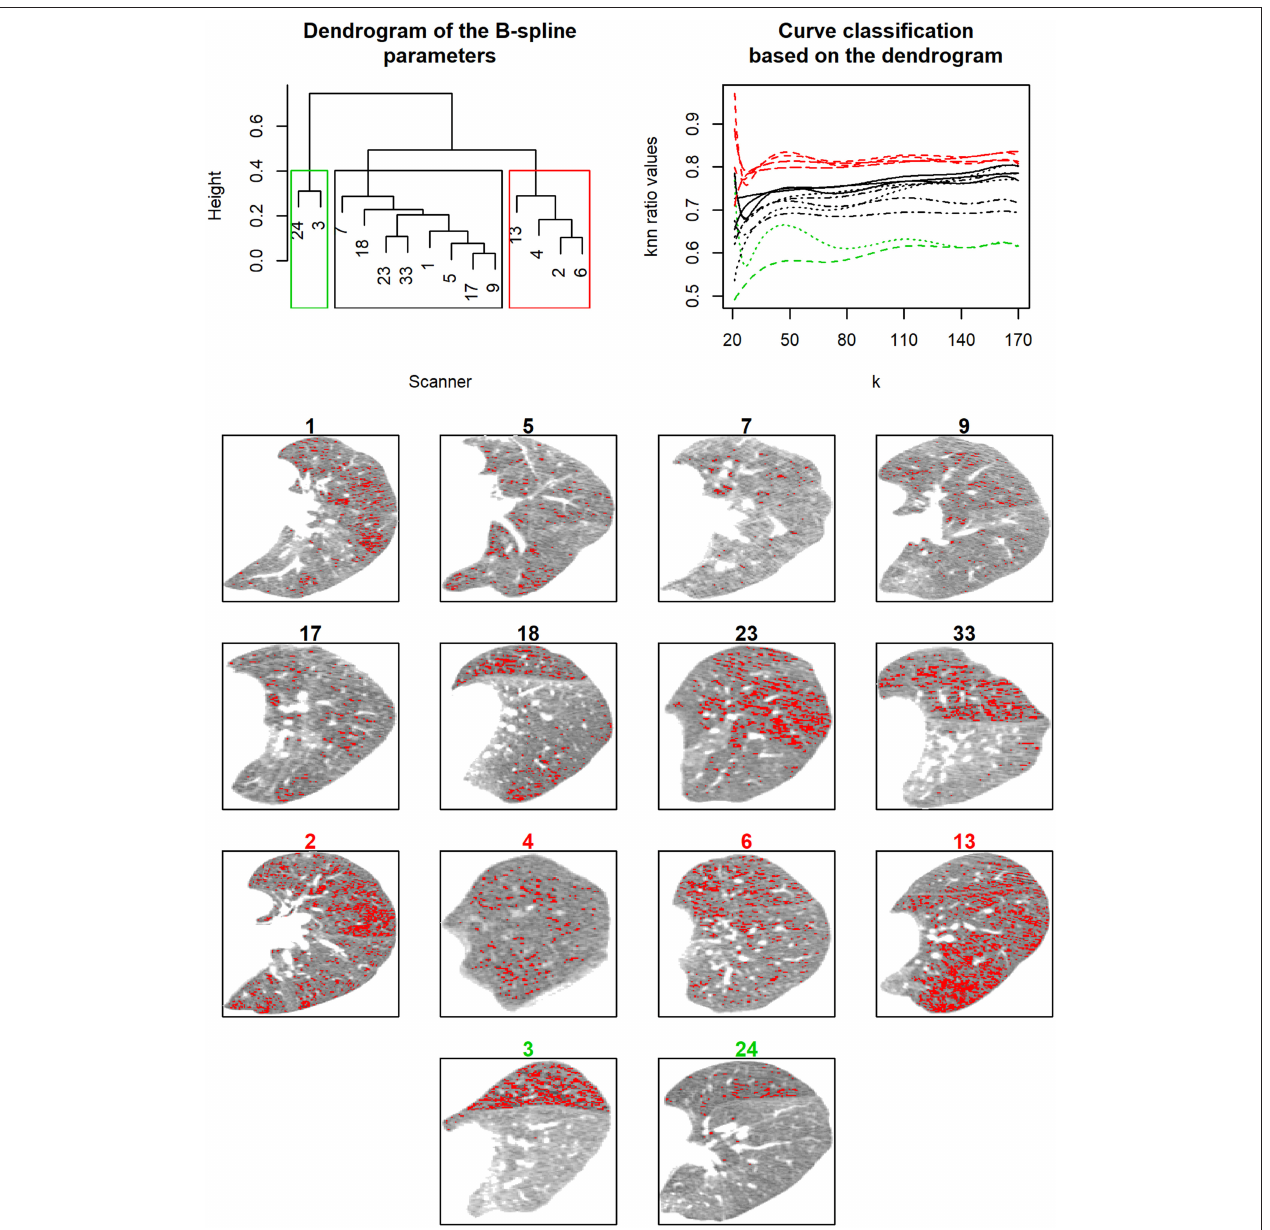
FIGURE 5 | Clinical application. Upper left: The dendrogram resulting from hierarchical ascendant classification using Ward’s method (complete linkage with UPGMA [16]) on spline parameters. Upper right: knn ratio value vs. k curves color-coded according to the hierarchical ascendant classification (red repartition, with air trapping distributed all over the parenchyma, black uniformity—point patterns are gathered in clusters). The CT scan images presented are number-colored according to dendrogram